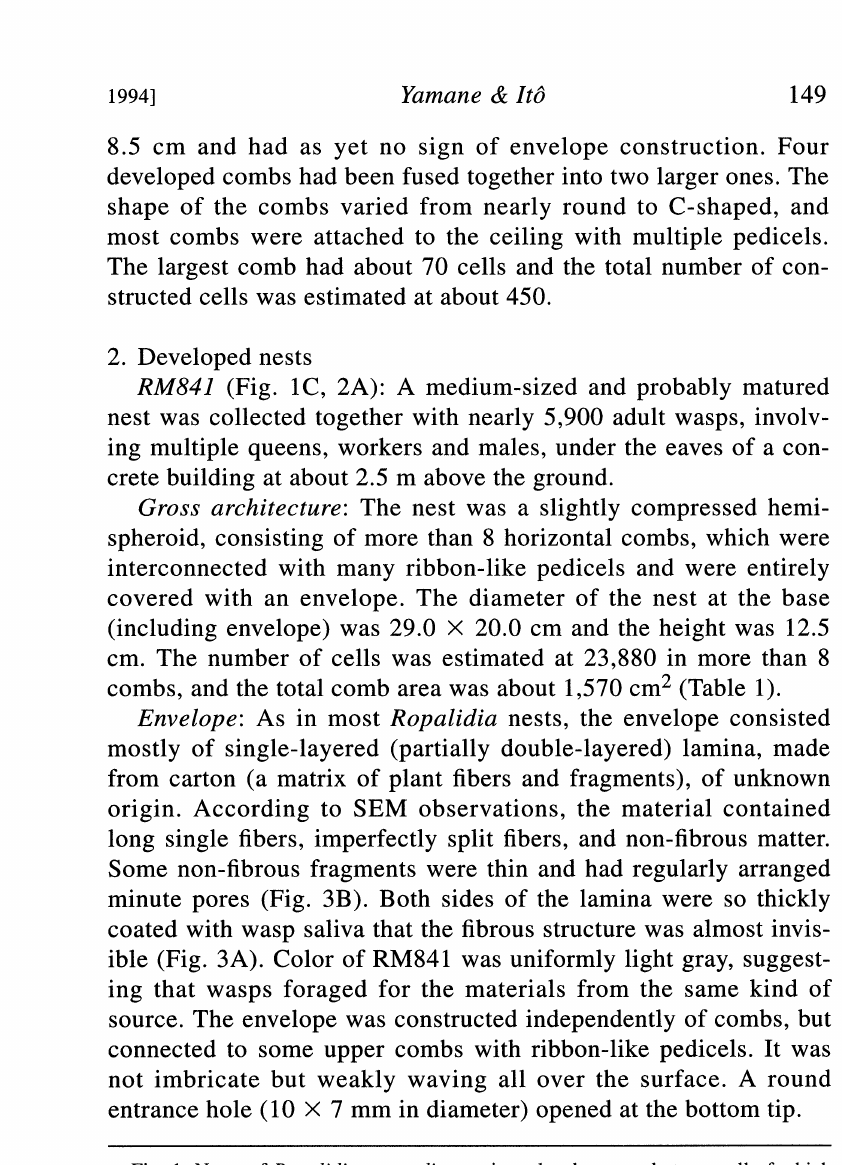
Fig. 1. Nests of Ropalidia romandi at various developmental stages, all of which were collected or observed in Queensland. A: Incipient nest (RM871) just founded underneath a palm leaf (15 September 1987, Cairns), B: Abandoned nest RM863 which was not covered yet (13 October 1986, Atherton), C: Medium-sized nest RM841 built under the eaves of concrete building (4 October 1984, Nathan), D: Nest RM862 built among branches of a mango tree. Lower combs are disclosed after collection (13 October 1986,